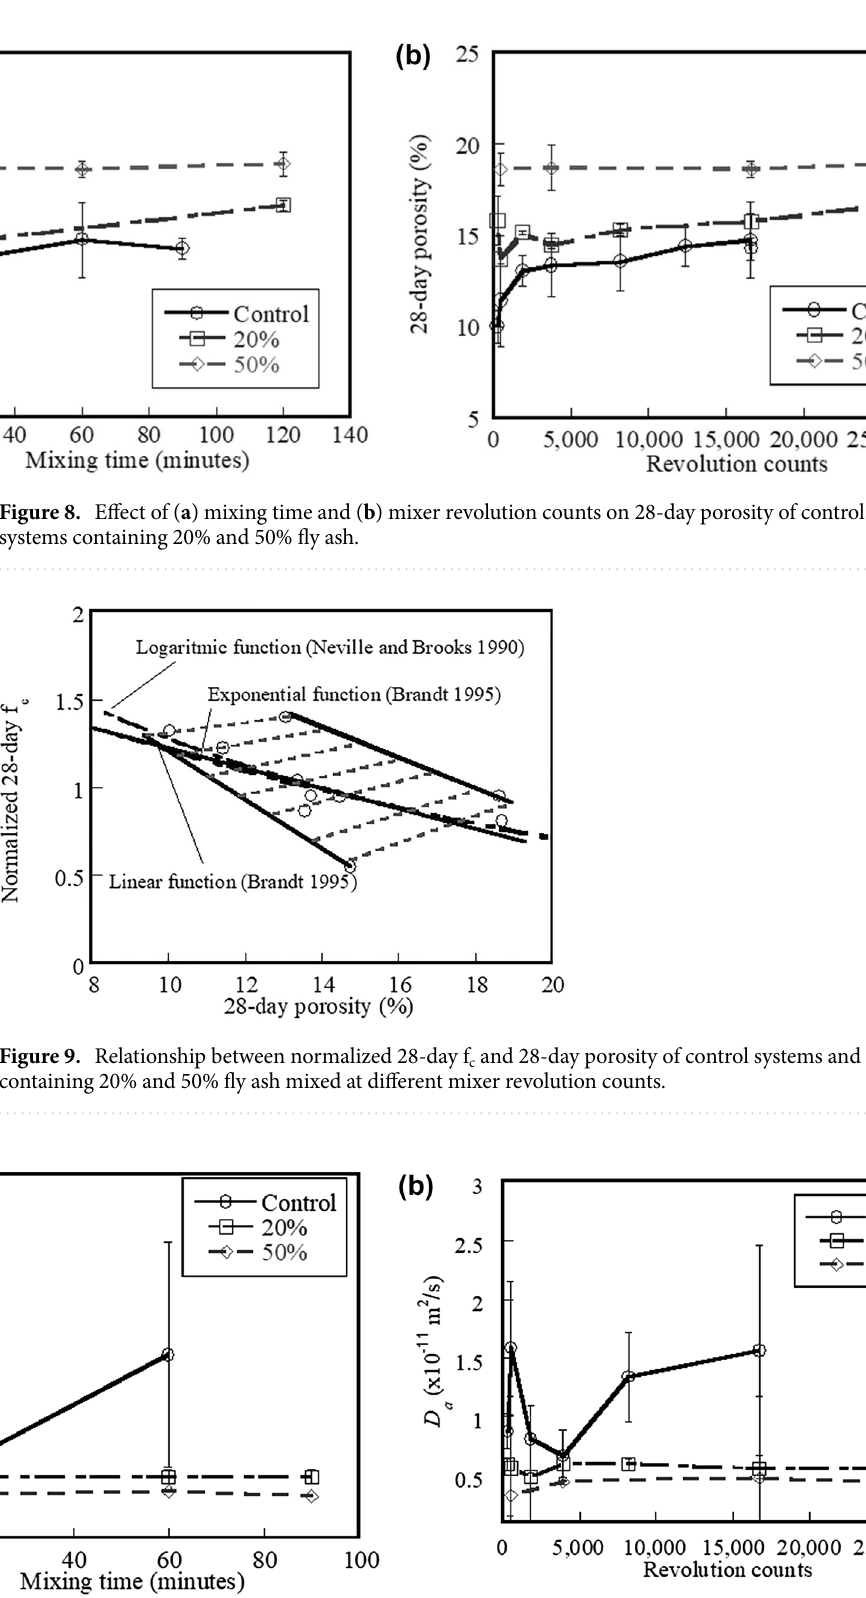
Figure 10. Effect of ( a ) mixing time and ( b ) mixer revolution counts on D a of control system and systems containing 20% and 50% fly